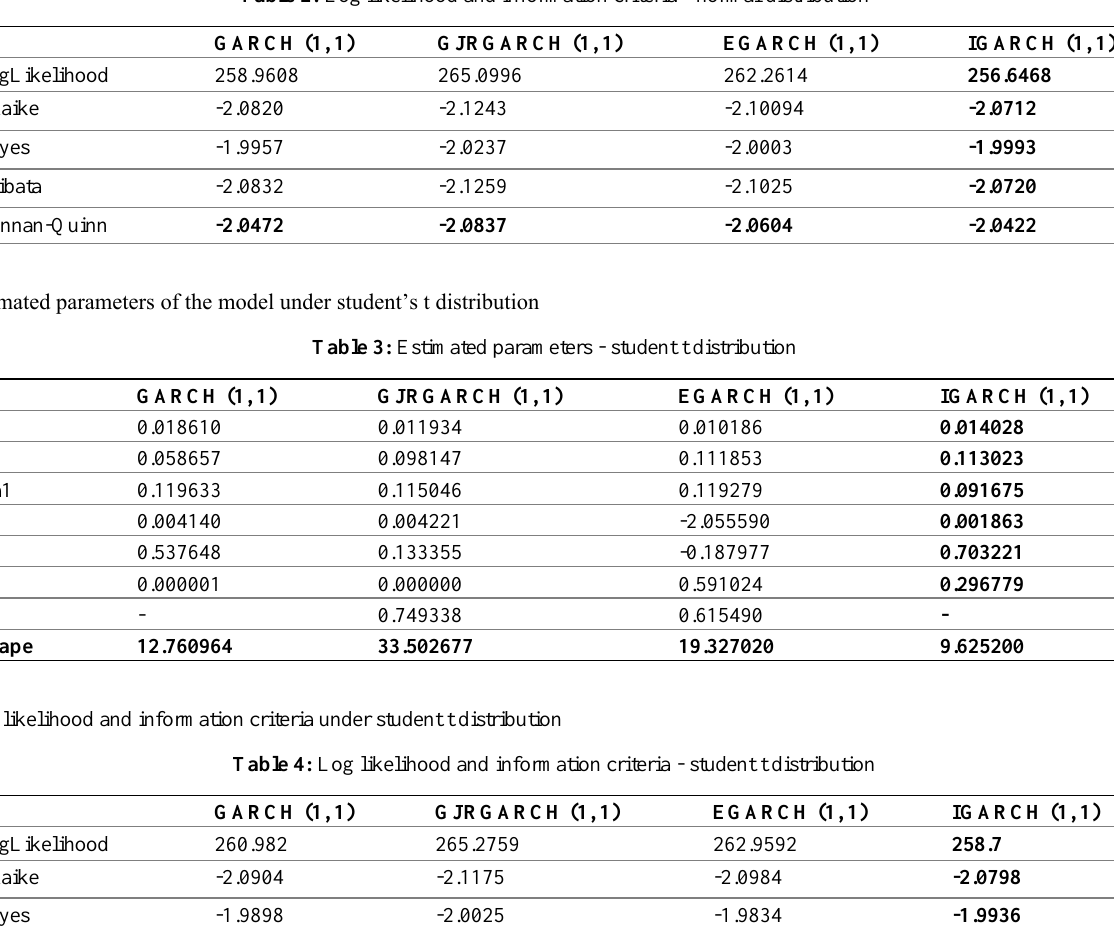
Table 2: Log likelihood and information criteria - normal distribution